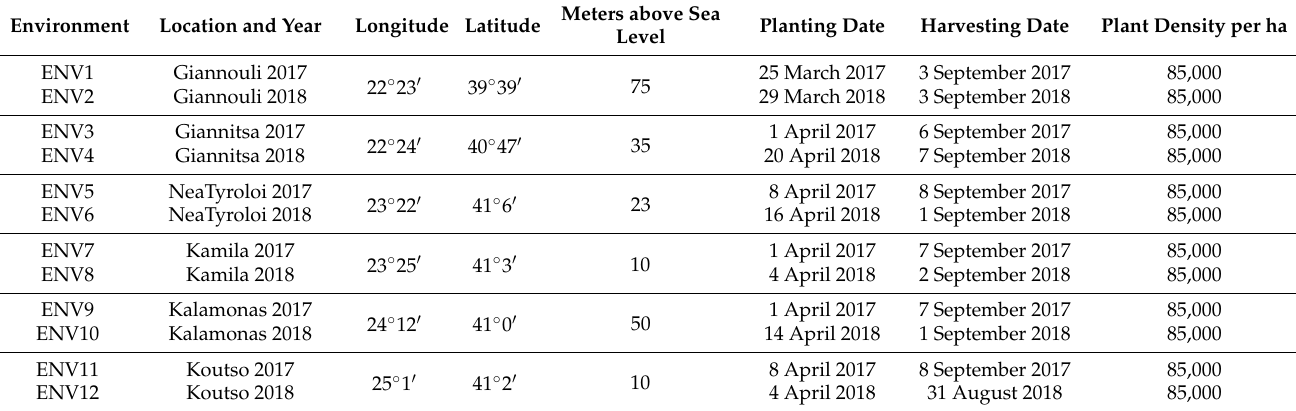
Table 1. Coordinates, altitude, and cultivation information for the 12 environments of the experiment. Environment